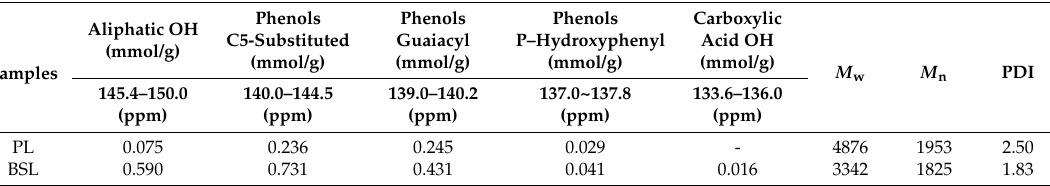
Figure 3. 31 P NMR spectra of PL, BSL. Table 1. Quantification of the functional groups (mmol/g) in the lignins of PL and BSL using aquantitative 31 P NMR method. Average relative molecular weight by GPC.